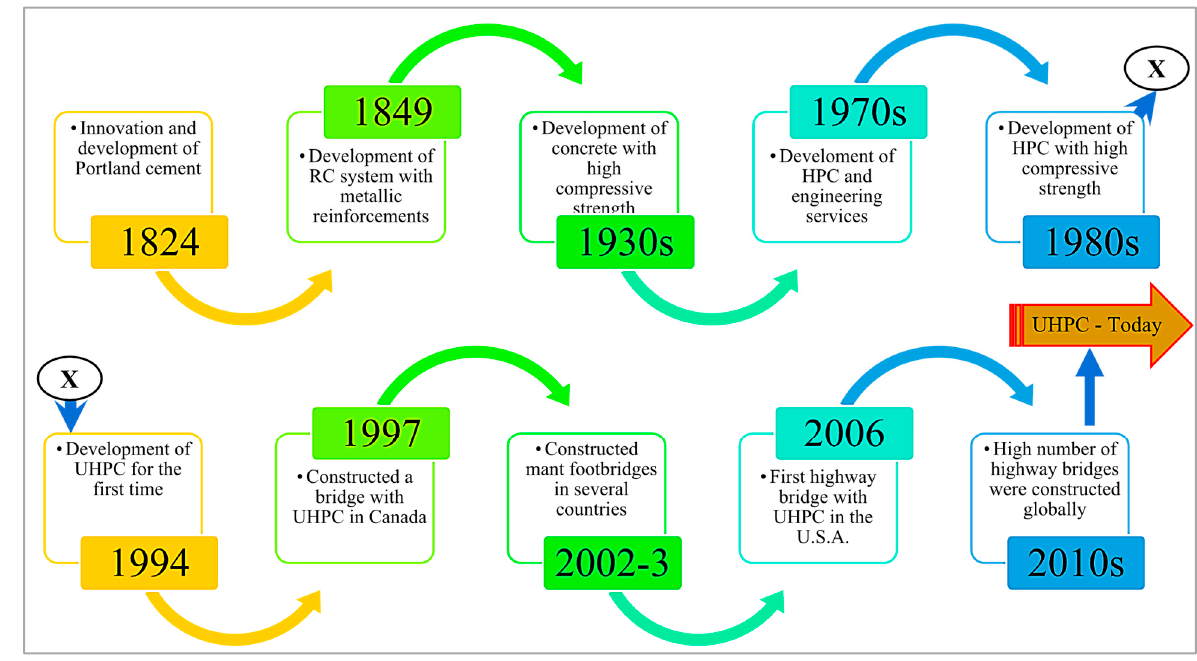
Figure 2. UHPC’s historical progress patterns [90] .